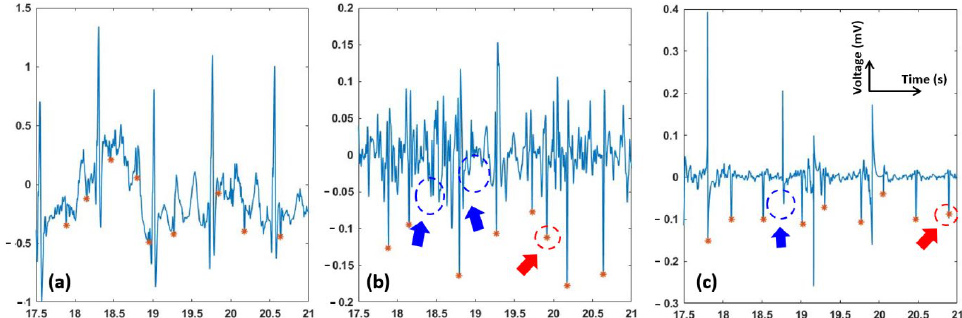
Figure 4. fECG extraction using the EKF and EnKF with the PhysioNet data. The fQRS annotation is shown in orange asterisk (*). The red arrows show the places that fetal QRS was wrongly detected. The blue arrows show the missing fetal QRS. ( a ) Abdominal ECG (raw data) of record “a03”; ( b ) fECG extracted using EKF of record “a03”; ( c ) fECG extracted using EnKF of record “a03”; ( d ) Ab- dominal ECG (raw data) of record “a01” with reversed fetal QRS complexes; ( e ) fECG extracted